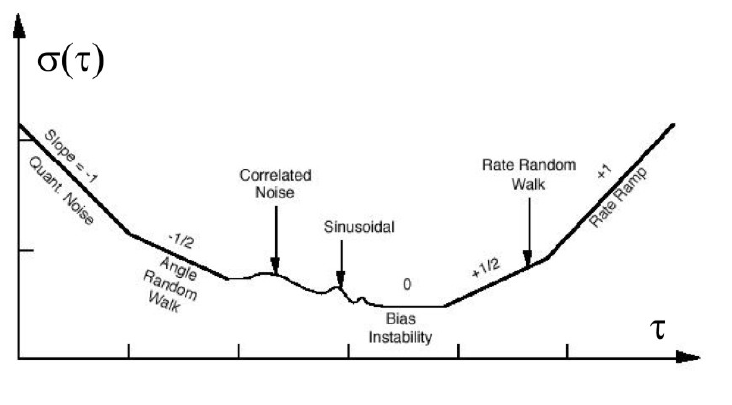
Figure 1. Generic Allan deviation plot in the clusters domain